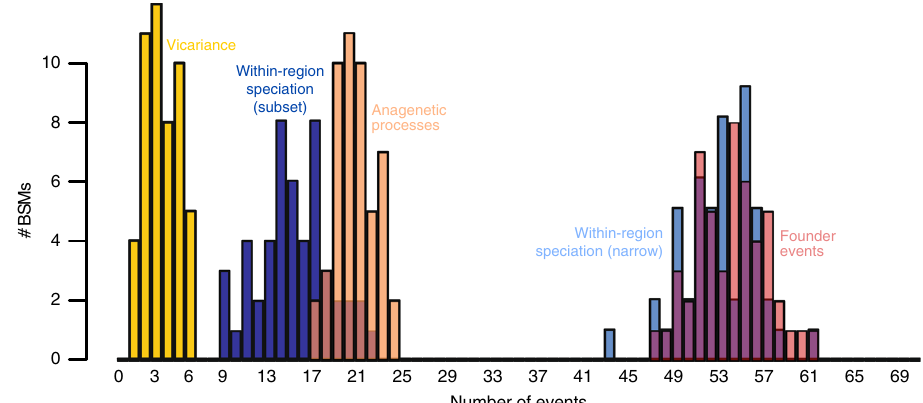
Fig. 3 Historical biogeography of the P. borealis complex. The fi gure depicts the probabilities of different biogeographic processes at each node in the P. borealis phylogeny, as assessed by Biogeographic Stochastic Mapping (BSM) in BioGeoBEARS. The histograms show the frequency distribution of the fi ve different types of historical biogeographical processes included in the favored model in BioGeoBEARS (DEC + j + x ) in 50 BSMs. The x -axis indicates the number of events, and the y -axis indicates the number of BSMs in which a certain number of biogeographic processes was observed. A visual representation of the considered historical biogeographic processes can be found in ref. 74